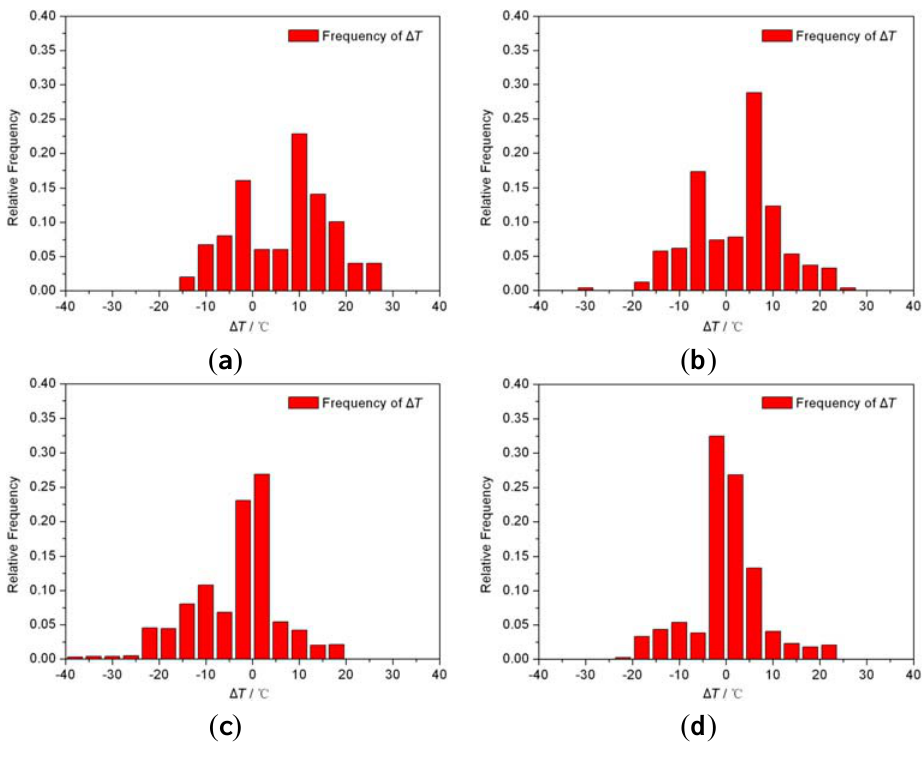
Figure 12. The frequency distributions of Δ T during the solidification time ( a ) SG1; ( b ) SG2; ( c ) SG3; ( d )